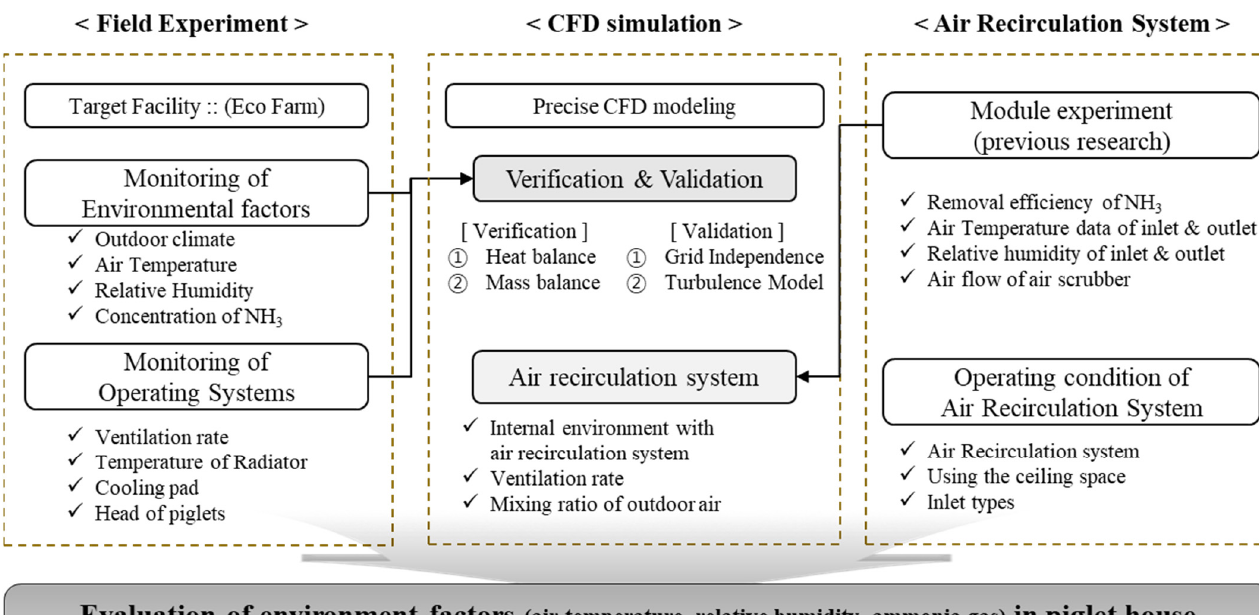
Figure 3. Flowchart of the analysis of internal environment for the development of the air-recirculated ventilation system .